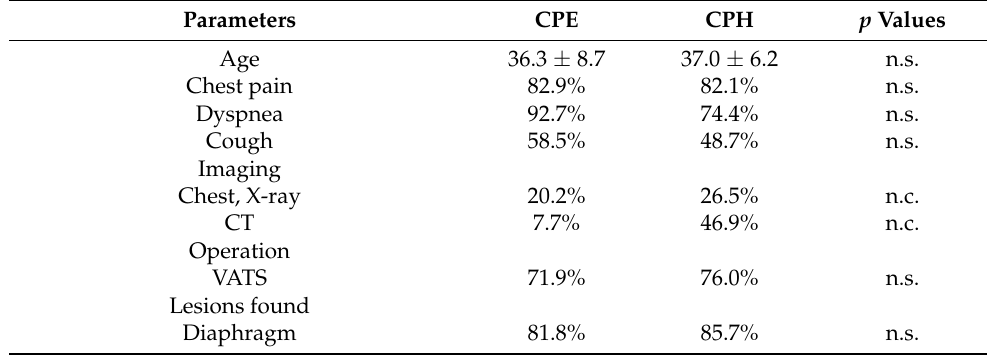
Table 1. Characteristics of patients with immunohistochemical compared to histological